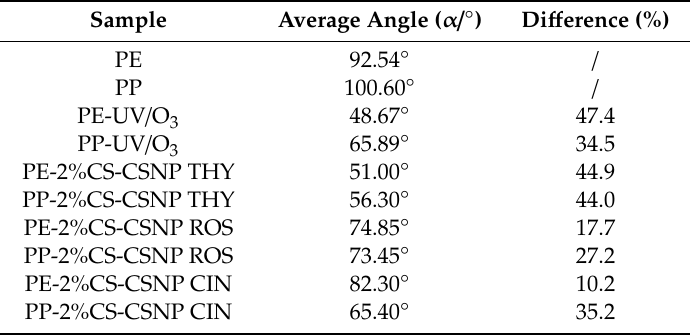
Table 10. Values of measurements for reference and functionalized